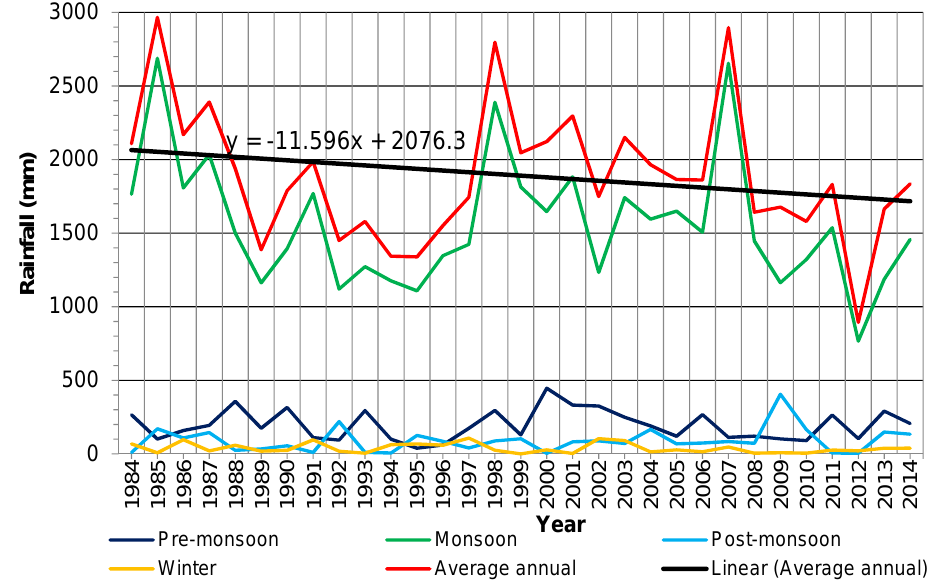
Figure 3. Variation of seasonal and average annual rainfall in the study area for the last 31 years.